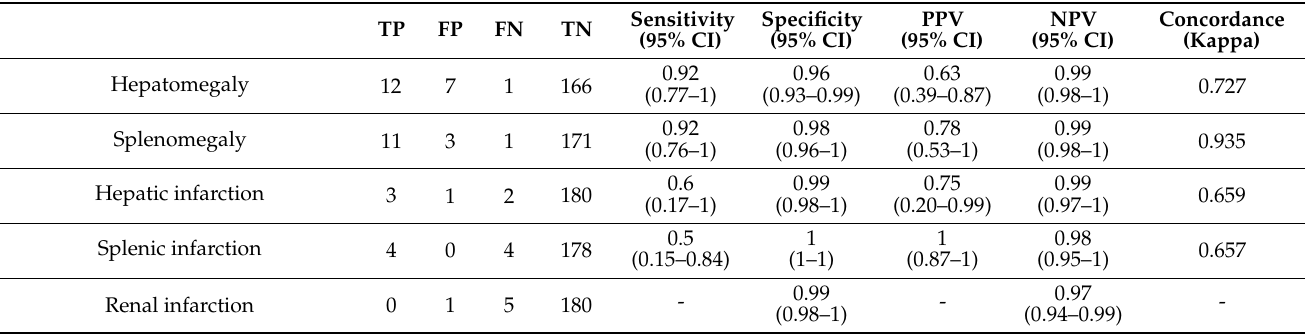
Table 6. Usefulness of POCUS for the detection of hepatomegaly, splenomegaly and septic embolisms in patients with bacteremia or